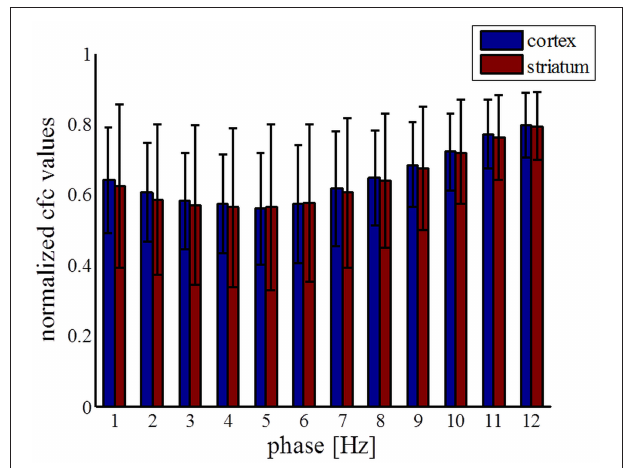
FIGURE 8 | Statistics of coupling values between phase of low frequencies and amplitude at 80Hz across all electrodes. Coupling values were normalized separately for each column by dividing all values with the maximum value across